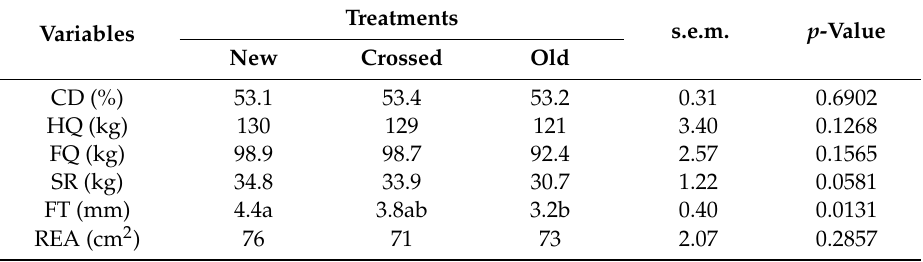
Table 7. Carcass traits and main cut weights of Canchim steers from di ff erent lines.